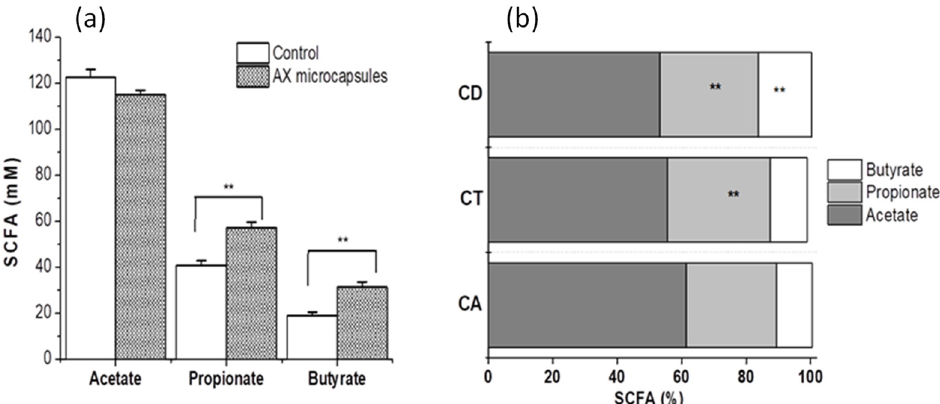
Figure 5. Average net SCFA production during control and AX microcapsule treatment ( a ). The average percentages of SCFA production in different colon compartments (CA, ascending; CT, transverse, and CD descending) of the SHIME system during treatment with AX microcapsules ( b ). Data represent the mean ± SD, n ≥ 4 per group. ** p < 0.05 compared to control.